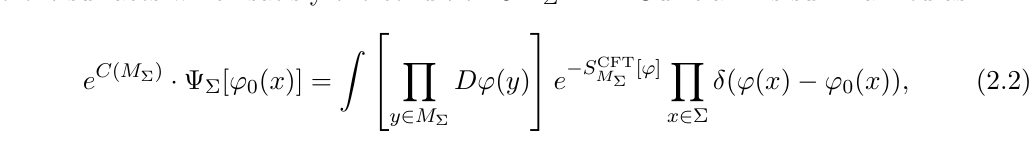
Figure 2 . Various constructions of the same state j (cid:9) (cid:6) i (i.e. the vacuum state in a CFT) from path-integrations on di(cid:11)erent surfaces M (cid:6) and their gravity duals. each state j (cid:9) i can be obtained from a regularized path-integration on a codimension one (cid:6) surface M , which ends on the surface (cid:6) i.e. @M = (cid:6). Refer to the right picture in (cid:6) (cid:6) (cid:12)gure 1. Note that the choice of M is not unique and indeed there are in(cid:12)nitely (cid:6)